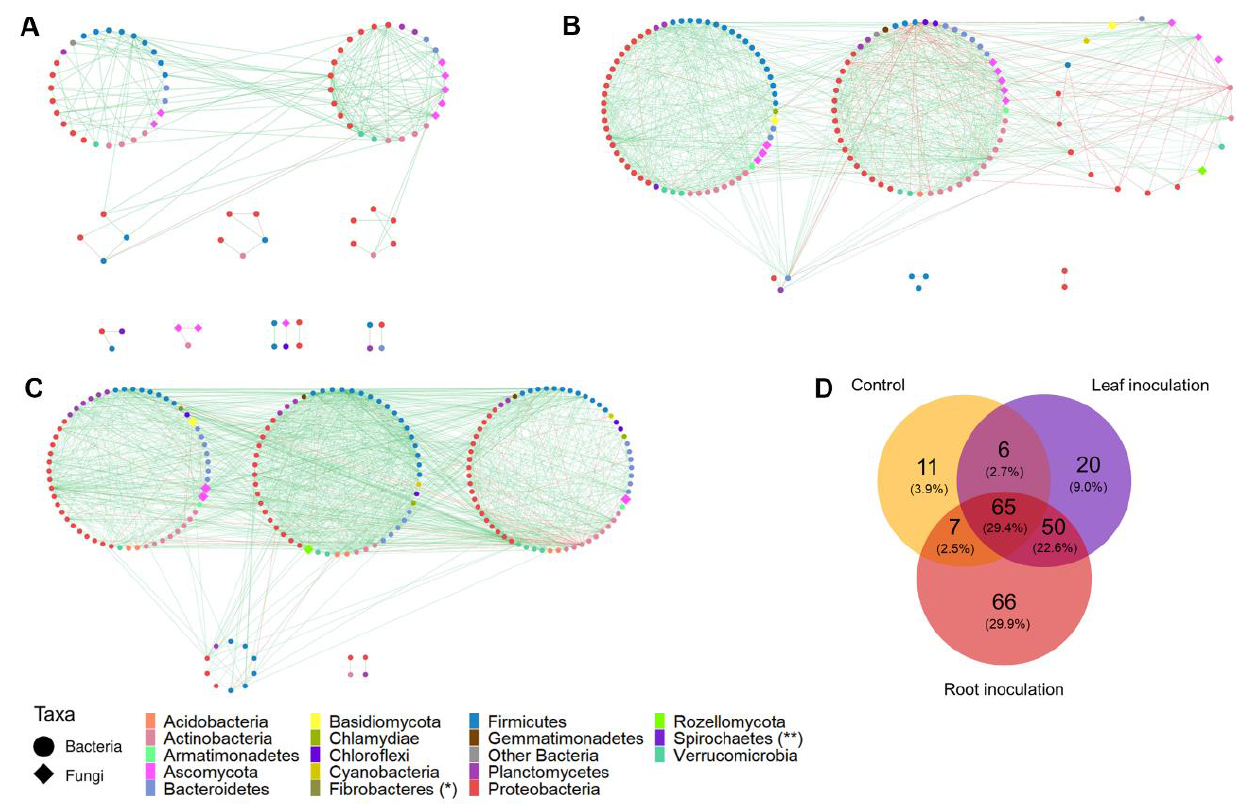
Figure 5. Co-occurrence networks of bacterial and fungal communities in control ( A ), leaf-inoculated ( B ), and root-inoculated ( C ) plants. The node and the edges represent microbial genera and the correlations among them, respectively. Each node is colored according to the phylum taxonomic level. (*) Phylum only in the network of the root-inoculated plants. (**) Phylum only in the network of the leaf-inoculated plants. ( D ) Venn diagram showing numbers of bacterial and fungal genera shared between the control samples and the leaf- and root-inoculated samples.